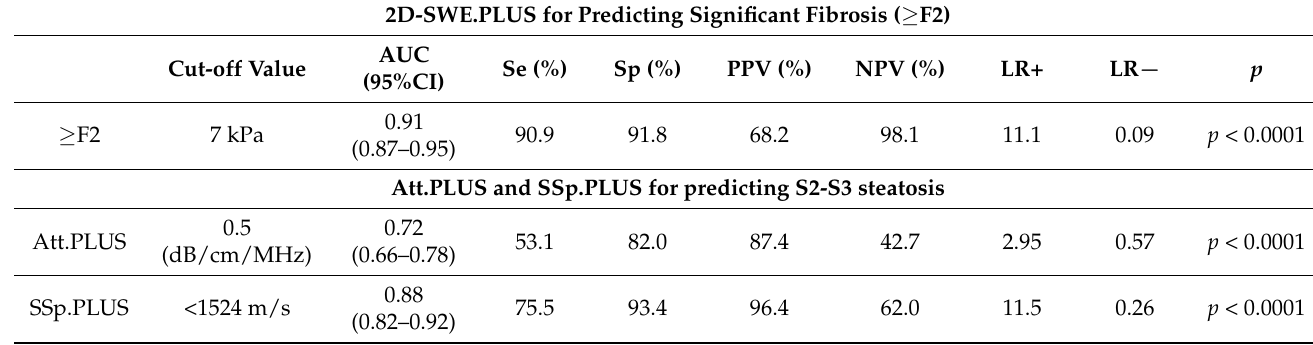
Table 3. Performance of 2D-SWE.PLUS for predicting significant fibrosis (F ≥ 2) and the performance of Att.PLUS and SSp.PLUS for predicting S2–S3 steatosis.